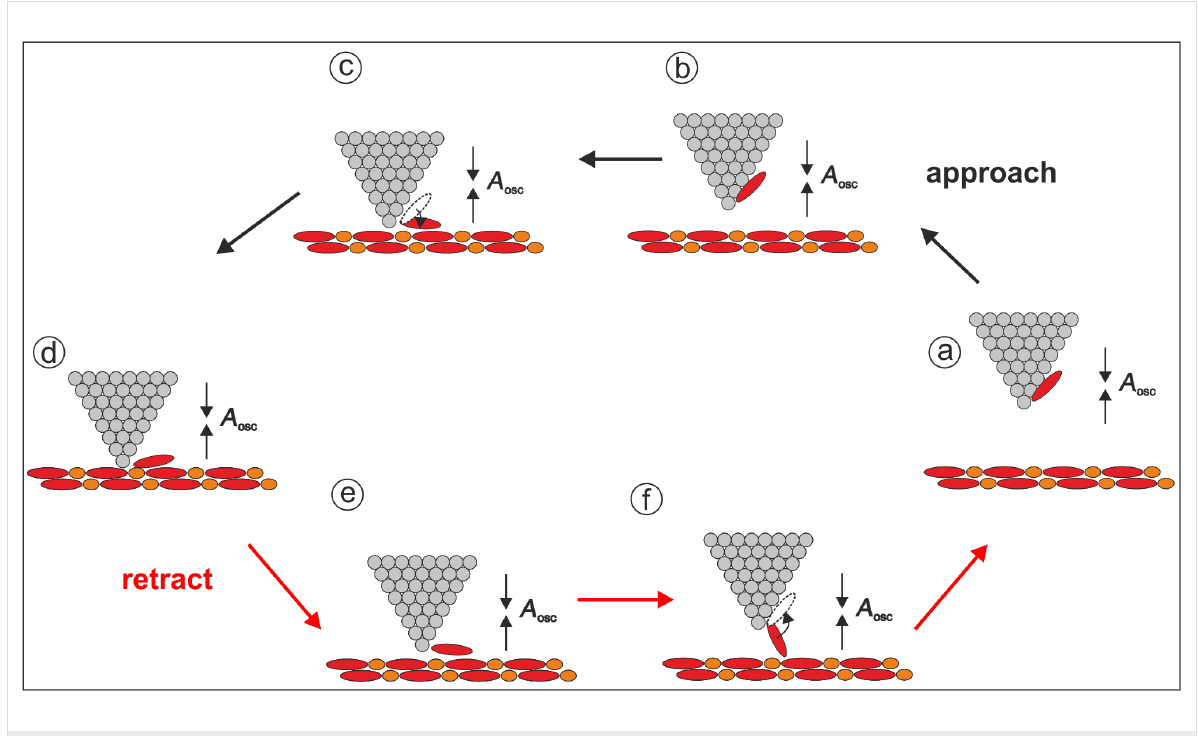
Figure 4: Scheme of the dissipation processes. The black arrows mark the different “snapshots” for the approach of the tip (upper part of the drawing), the red arrows for the retraction (lower part of the drawing). At points (c) and (f) the molecule at the tip abruptly flips to a new position thereby dissipating energy into short-lived vibronic excitations. This energy is given by the work done by the tip as can be seen from the hysteresis in the force distance curves. While the molecule is bridging the gap a second dissipation process occurs, which results in the damping of the oscillation of the